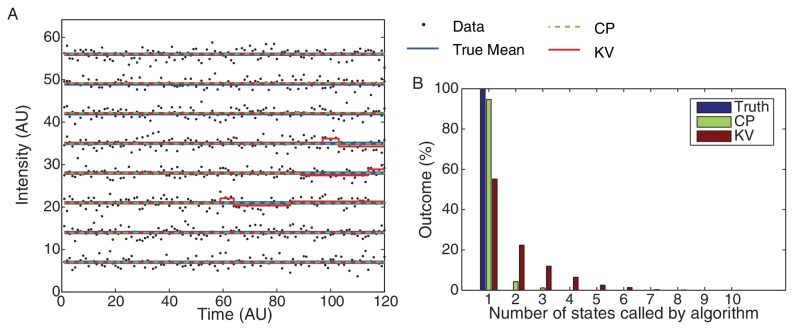
CP vs KV filtering algorithm.(A) Eight typical datasets (black dots) are plotted with the true mean (blue) and idealizations using both the KV (red) and CP (green) algorithms. The simulated data consisted of 10,000 Gaussian processes with unit variance simulated for 120 frames each. The over segmentation generated by the KV algorithm is clearly visible in the (false) transitions shown in the third, fourth, and fifth traces. No false steps were observed in these eight traces using the CP algorithm. (B) The total number of states for the 10,000 simulated datasets is shown for the true mean and the CP and KV idealization. All datasets consisted of a single true level. The true number of states (one) was found 95% of the time using the CP algorithm and only 55% of the time using the KV algorithm.